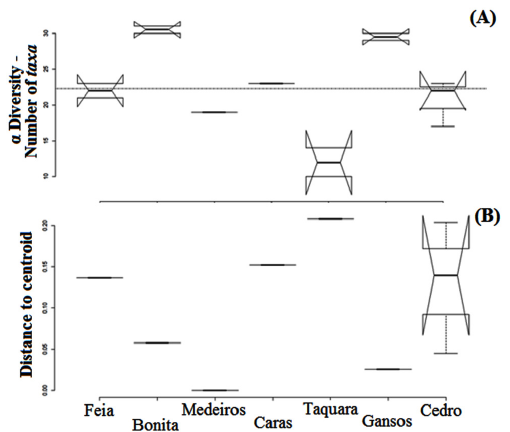
Figure 3. Average values (bold line), maximum and minimum (bars), third and first quartile (box), of the α diversity (A) and β diversity (B) in the seven sampling points (shallow lakes).